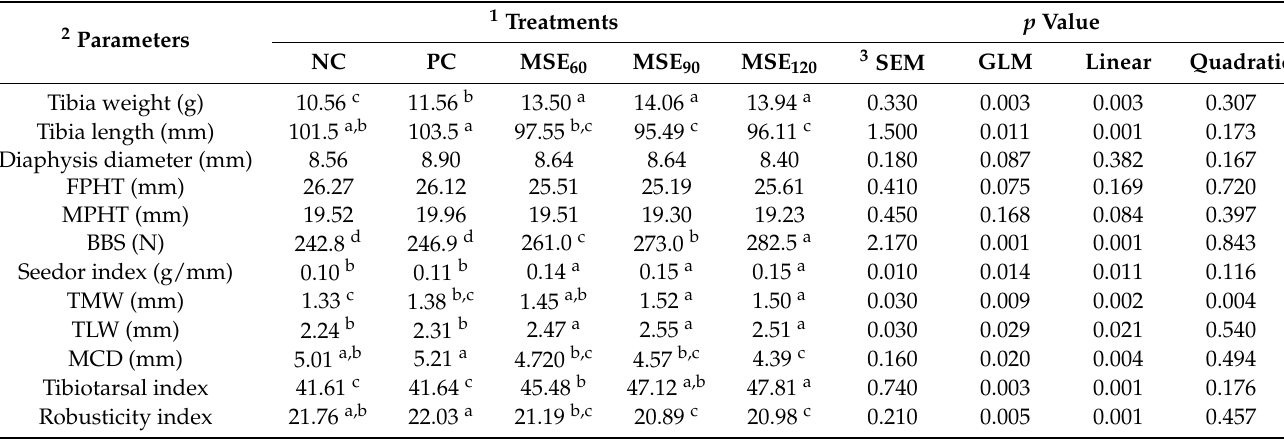
Table 4. Tibia morphometric parameters of six-week-old broiler chickens ( n = 125) orally administered with varying levels of moringa seed extract (MSE) in drinking water.